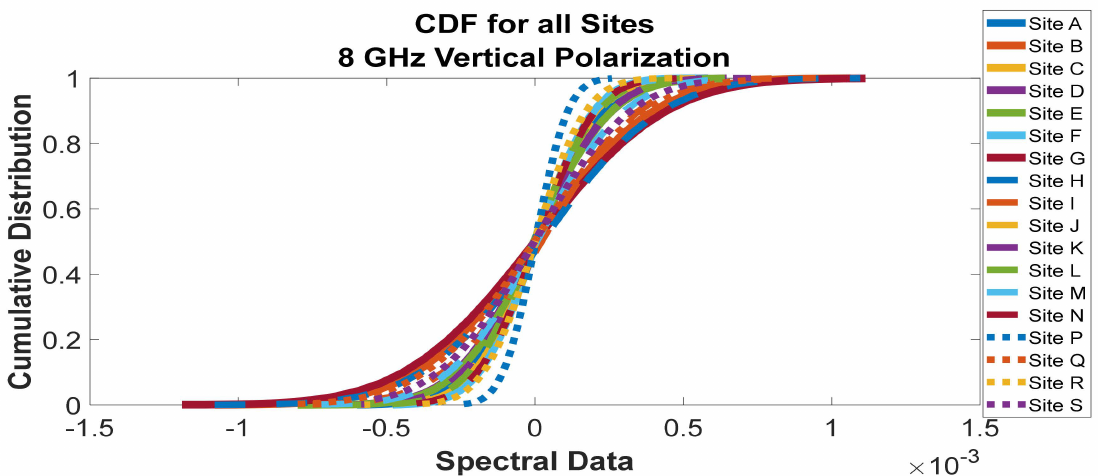
Figure 40. Cumulative distribution functions of frequency scan for all sites at 8 GHz vertical